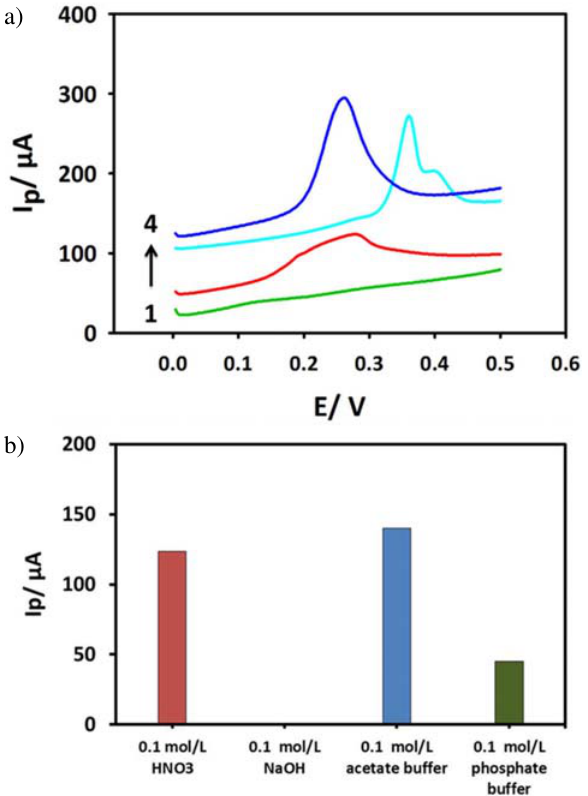
Figure 8: a) Square wave anodic stripping voltammograms Figure 9: a) Square wave anodic stripping voltammograms (SWASVs) and b) corresponding histograms of 6.2 × 10 –7 mol/L (SWASVs) of 6.2 × 10 –7 mol/L Hg(II) at GPE surfaces in 0.1 mol/L Hg(II) at GPE surfaces in a) 0.1 mol/L NaOH b) 0.1 mol/L phosp- acetate buffer at pH 1) 3.2, 2) 4.0, 3) 4.8, 4) 5.5, 5) 6.0 and 6) 6.5. and d) 0.1 mol/L acetate buffer. hate buffer, c) 0.1 mol/L HNO Pretreatment CV segments, 20; other working conditions are iden- 3 Pretreatment CV segments, 20; other working conditions are iden- tical to those in Fig. 2a. b) Corresponding plot of pH vs peak cur- tical to those in Fig. 4a. rent.